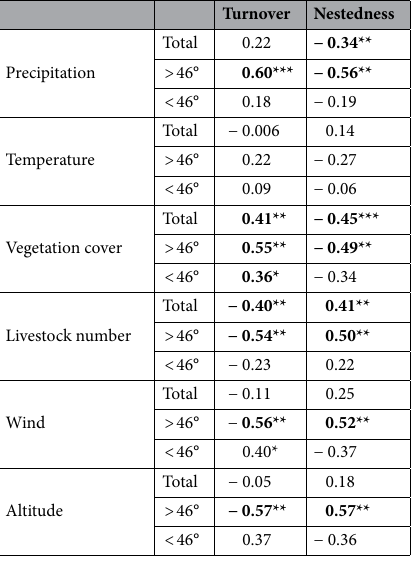
Table 2. Pearson correlation coefficients between environmental variables and beta diversity measurements for total (along whole latitudinal gradient), above (> 46°) and below (< 46°) the 46° of latitude. Significant variables are shown in bold with stars indicating the level of